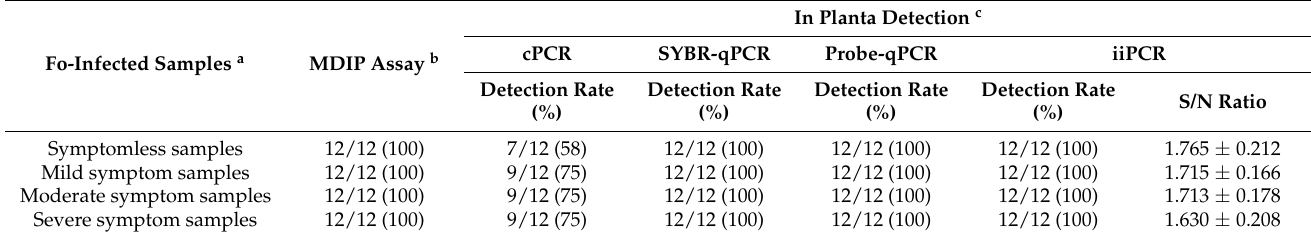
Table 6. Comparison of Fo iiPCR and the molecular detection methods for field detection of various Fusarium oxysporum -infected asymptomatic and symptomatic banana pseudostem samples using a rapid DNA extraction